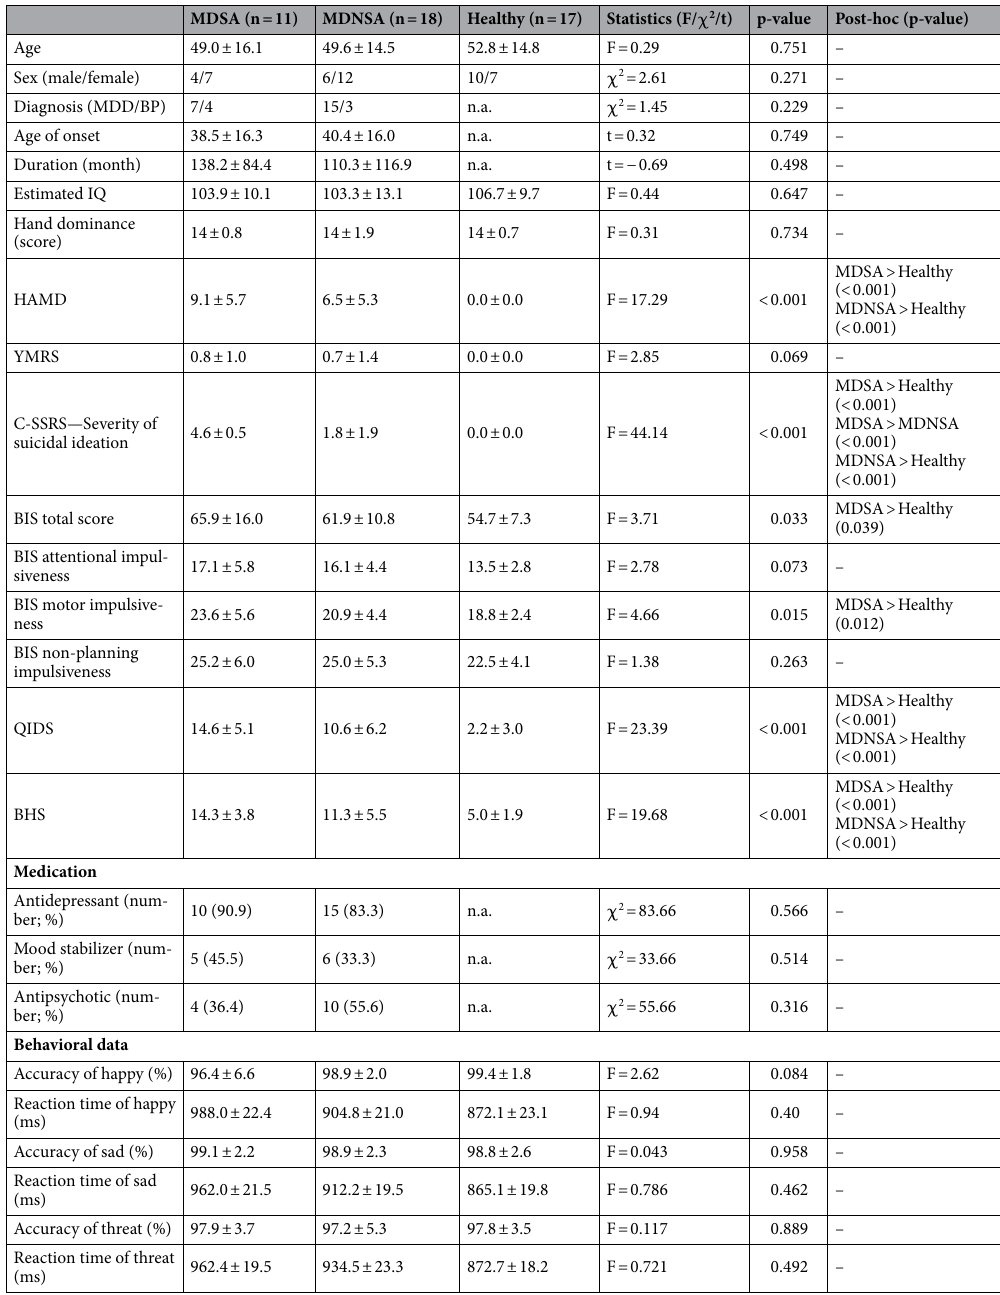
Table 1. Demographics, characteristics, and behavioral data of the participants. Mean ± SD, n (%), not applicable. MDSA mood disorder patients with a history of suicide attempt, MDNSA mood disorder patients with no history of suicide attempt, MDD major depressive disorder, BD bipolar disorder, HAMD Hamilton Depression Rating Scale, YMRS Young Mania Rating Scale, C-SSRS Columbia Suicide Severity Rating Scale, BIS Barratt Impulsiveness Scale, BHS Beck Hopelessness